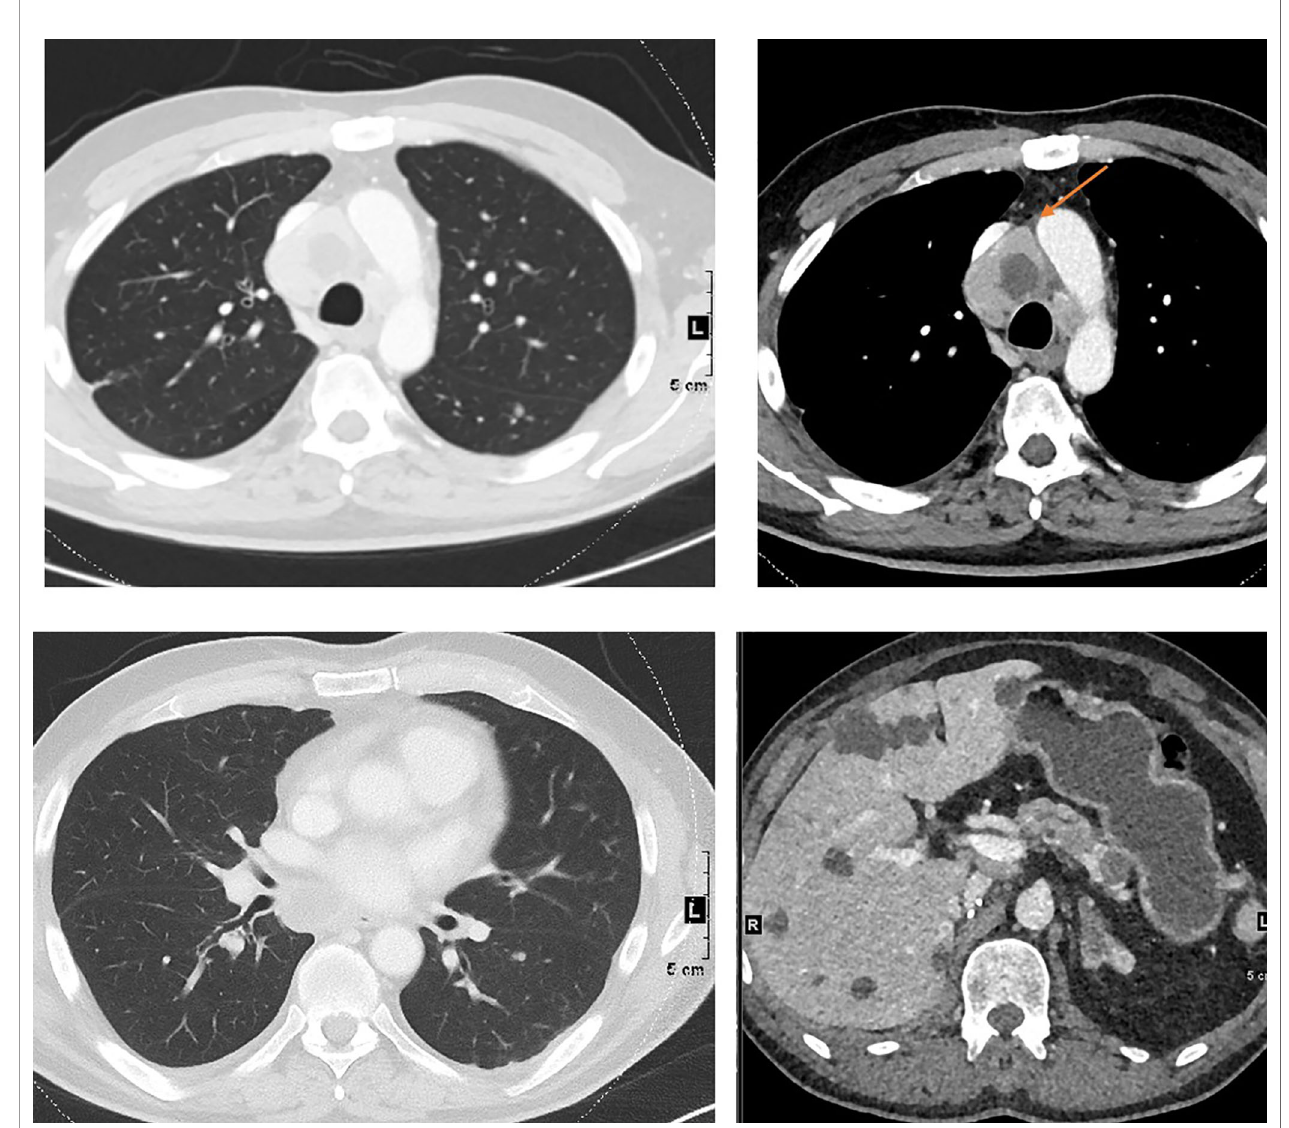
FIGURE 4 | Mixed response to treatment in the same patient illustrated in Figure 1 . Eight weeks after targeted therapy lung, adrenal and pancreatic metastases decreased, whereas one mediastinal lymph node (top right, arrow)